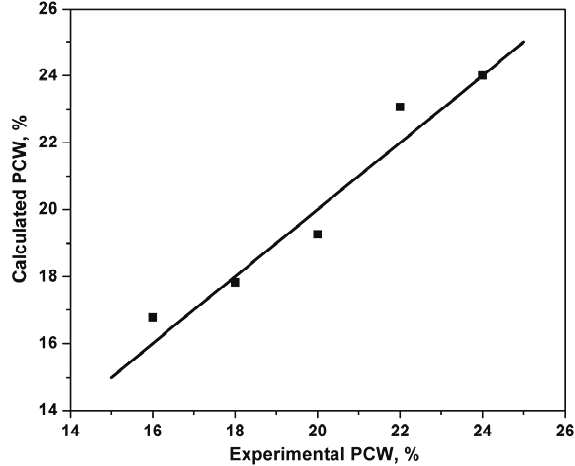
Figure 5. True stress-true plastic strain plot of 22 % PCW material at 298 K fitted with Swift equation. Figure 6.